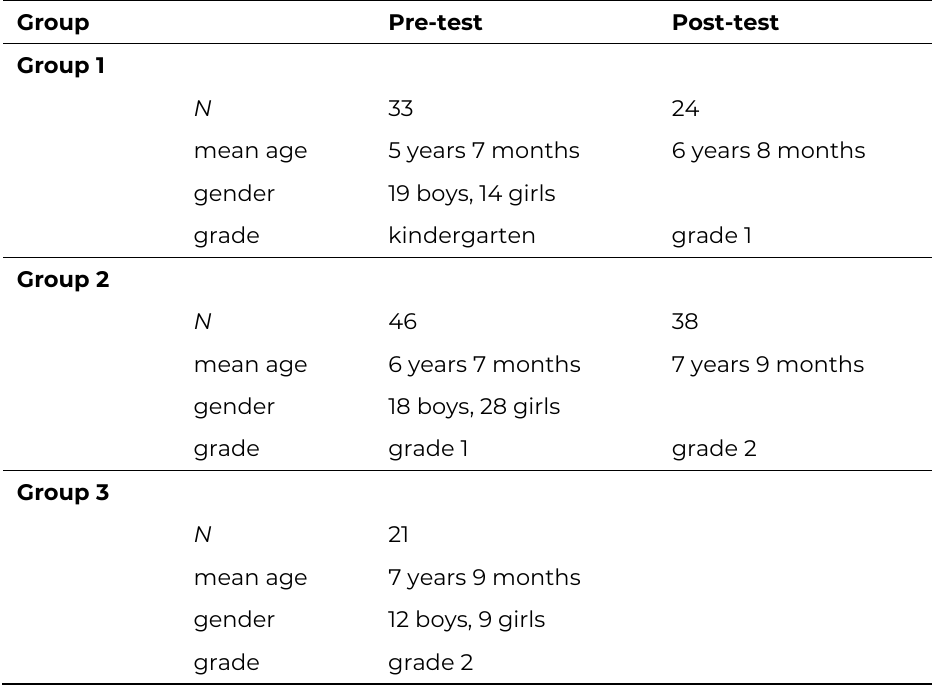
Table 1: Demographic information for